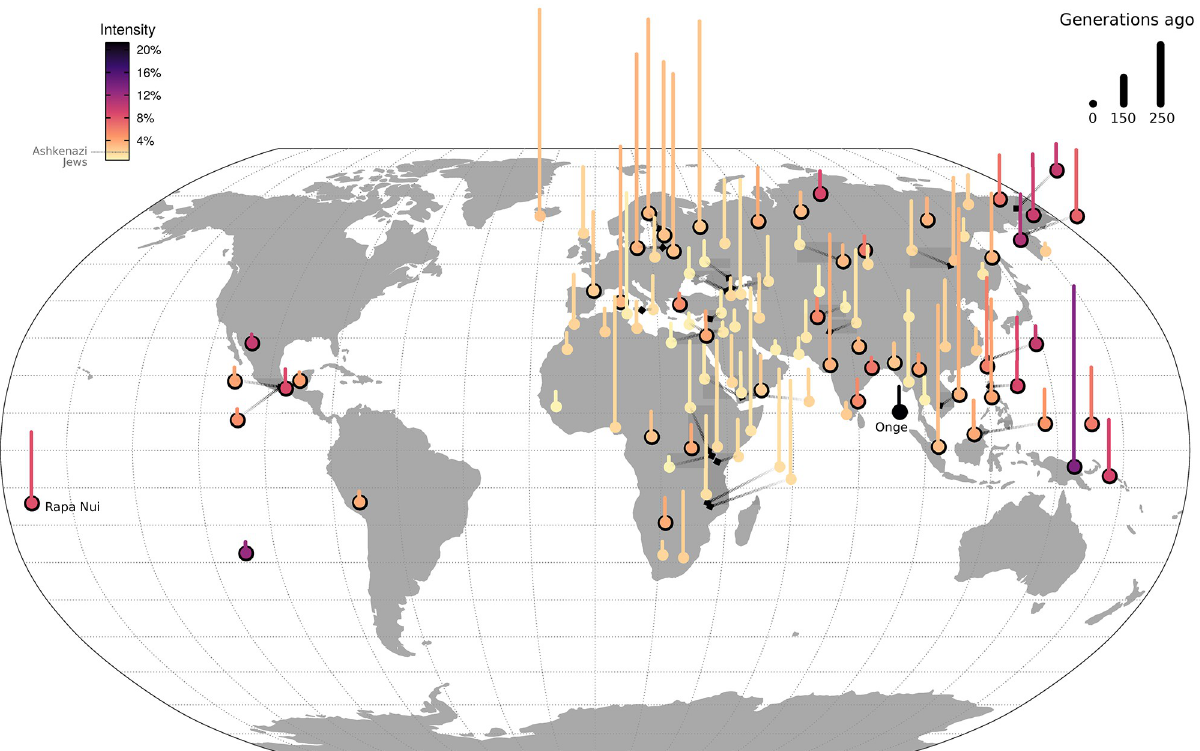
Fig 2. History of founder events in present-day human populations. Results of ASCEND for present-day populations in the Human Origins v37 dataset that passed filtering criteria and showed significant evidence of founder events (see Methods). Each point shown represents a population and the vertical segment represents the age of its associated founder event (where the segment length is proportional to the founder age). To avoid overplotting in certain areas, we shifted the location of a few populations and indicated their original location (black diamond point) with an arrow getting darker towards the original location. The color gradient of the points and segments is proportional to the estimated founder intensity. Points with a black border represent populations which have experienced significantly stronger founder events than Ashkenazi Jews (shown in legend for reference). The strongest founder event is estimated for the Andamanese population Onge (21.2%). The world map was obtained from the R package maps with GPL-2 public license.